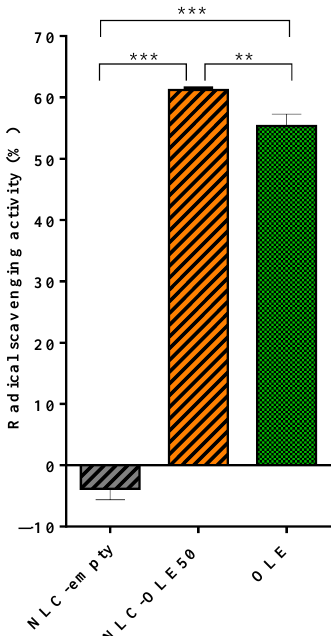
Figure3. 2,2-diphenyl-1-picrylhydrazyl(DPPH)radicalscavengingassayofNLC-OLE50andequivalent amounts of free OLE and NLC-empty. Results are expressed as mean % of DPPH radical scavenging activity compared to the control ± SD; n = 3; ** p < 0.05, *** p < 0.001.